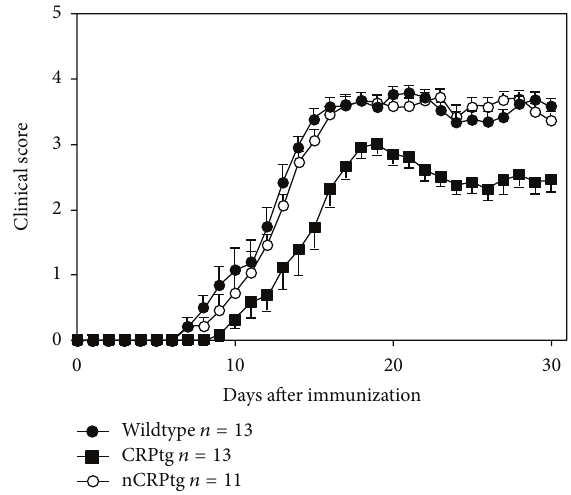
Figure 5: CRPtg, but not nCRPtg mice, are resistant to EAE. Wildtype, CRPtg, and nCRPtg mice were immunized with MOG peptide and symptoms of EAE were monitored over the course of 30 days. EAE onset was significantly delayed and its symptoms ameliorated in CRPtg, but not in nCRPtg (see Table